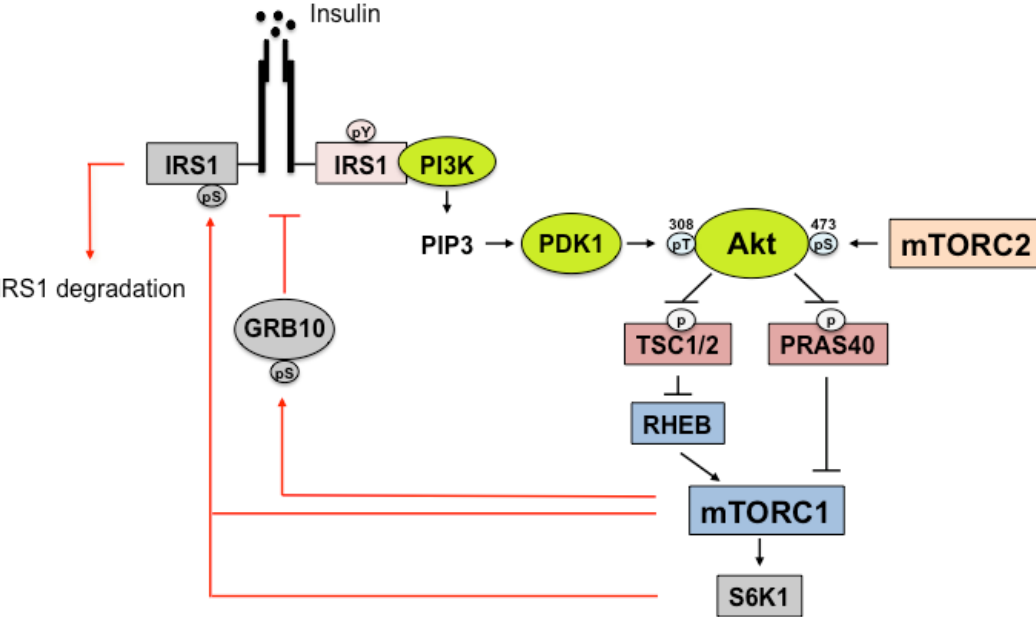
Figure 2. Negative feedback regulation of insulin receptor substrate (IRS) by rapamycin complex 1 (mTORC1) Activated mTORC1/S6K1 inhibits IRS-1 by phosphorylating serine residues. mTOR phosphorylates mouse (m)S632 (human (h)S636), mS307 (hS312), and mS612 (hS616), and S6K1 phosphorylates mS302 (hS307), mS522 (hS527), mS265 (hS270), and mS1097 (hS1101). mTORC1 phosphorylates and stabilizes Grb10, which inhibits the interaction between IRS and the phosphorylated tyrosine of IR. Akt indirectly activates mTORC1 by phosphorylating tuberous sclerosis complex (TSC) and PRAS40. The gray images are mTORC1 targets in insulin signaling. The red line represents negative regulation. S6K1, ribosomal protein S6 kinase 1; pY, phosphotyrosine; pS, phosphoserine; PI3K, phosphoinositide 3-kinase; PIP3, phosphatidylinositol (3,4,5)-triphosphate; PDK1, 3-phosphoinositide-dependent protein kinase 1; pT, phosphothreonine; Akt, protein kinase B (PKB); GRB10, growth factor receptor-bound protein 10; PRAS40, proline-rich AKT substrate of 40 kDa; RHEB, RAS homolog enriched in the